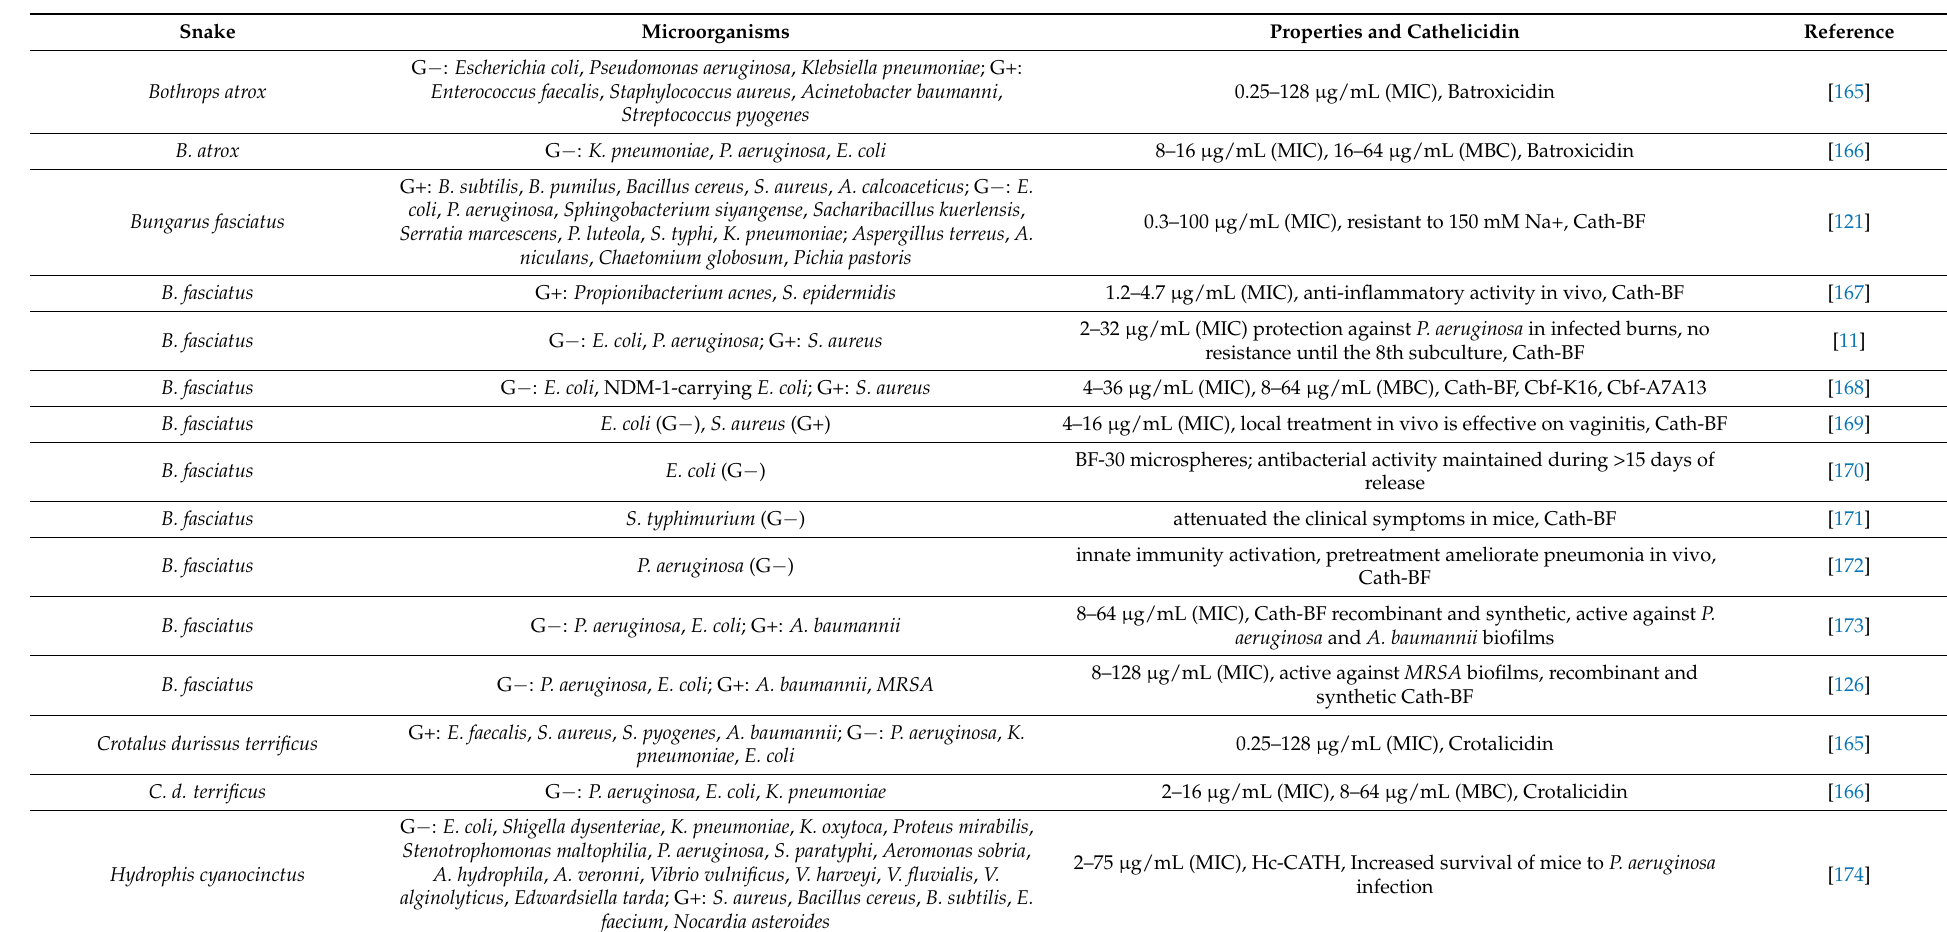
Table 5. Activity of snake cathelicidins on